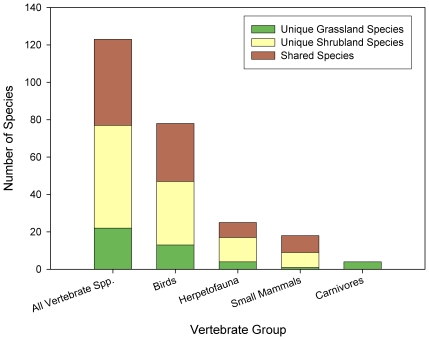
Vertebrate species richness in grassland and shrubland habitats.Total number of shared and unique species of all vertebrate groups combined, birds, small mammals (including lagomorphs), herpetofauna, and carnivores on the grassland and shrubland habitats over all sample periods (1994, 1995, 1996, 2000, 2001, 2002, 2003, and 2004; see Table A3 for specific sampling periods for each group).